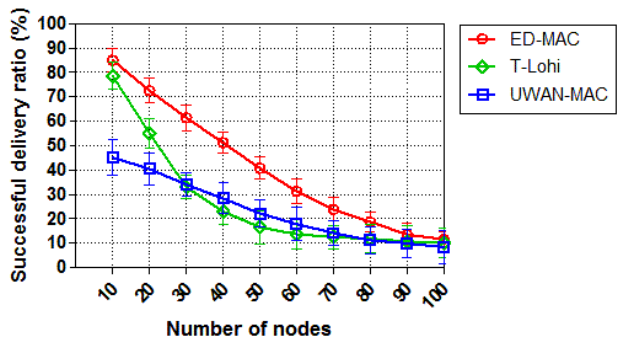
Figure 12. Successful delivery ratio vs. node